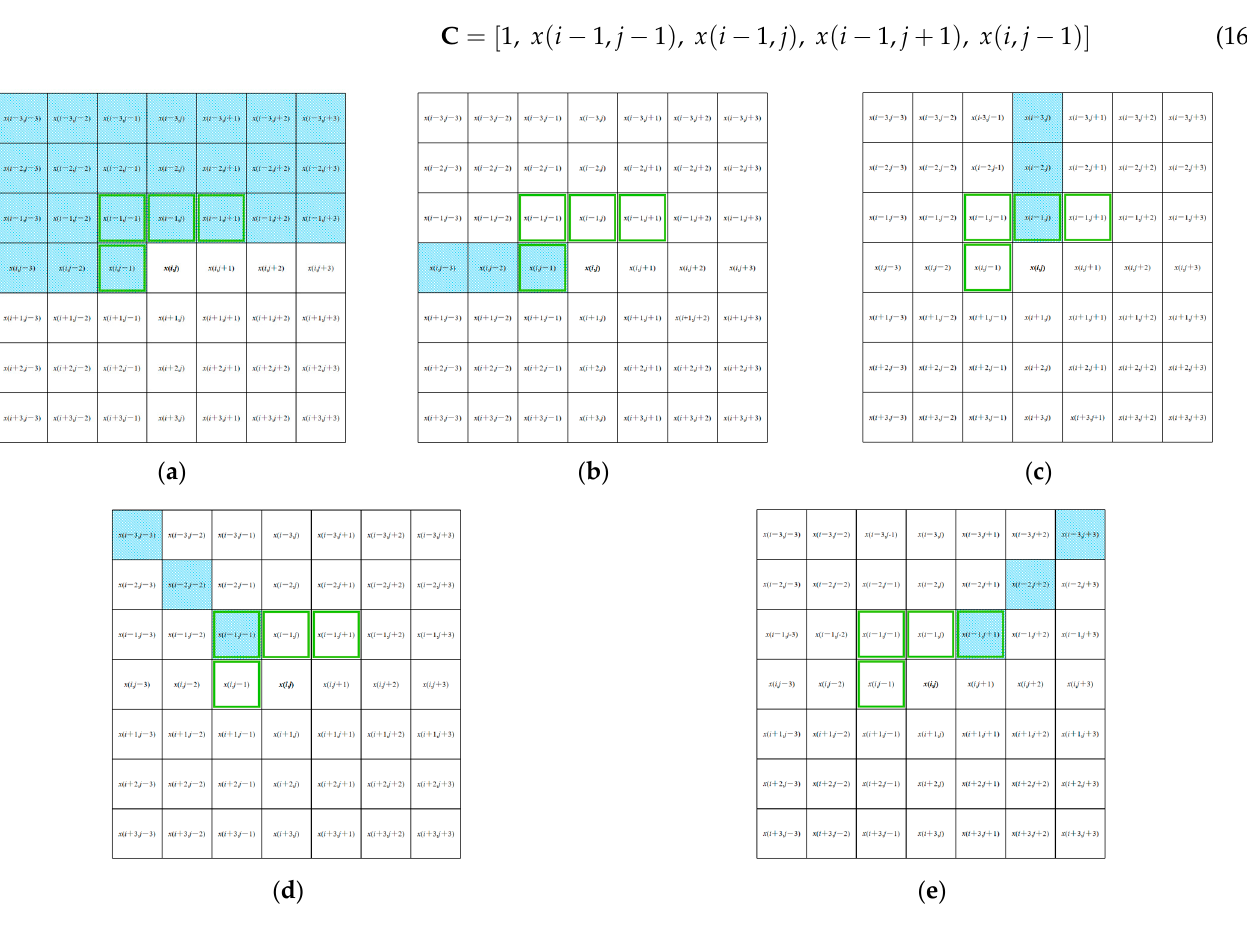
Figure 3. Training pixels and prediction context of the target pixel x ( i , j ): ( a ) Weak edge; ( b ) Horizontal edge; ( c ) Vertical edge; ( d ) Positive diagonal edge; and ( e ) Negative diagonal edge.